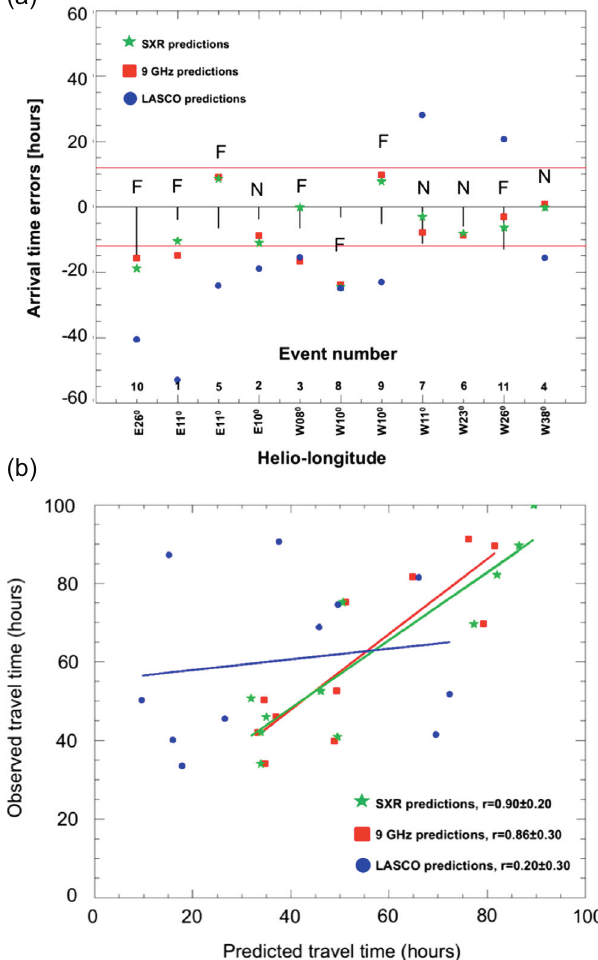
Fig. 7. Errors in arrival time predictions. (a) Travel time errors (predicted – observed arrival times) ordered by increasing longi- tude. The numbers on the abscissa are the event numbers in Table 3. Green stars: SXR proxy. Red squares: / 9 GHz . Blue circles: LASCO coronographic observations ( V EXP = 2 V CAT ). The red lines mark the ±12 h error window while the black vertical lines, the interval between the shock and ICME arrivals. (b) Correlations between observed and predicted travel